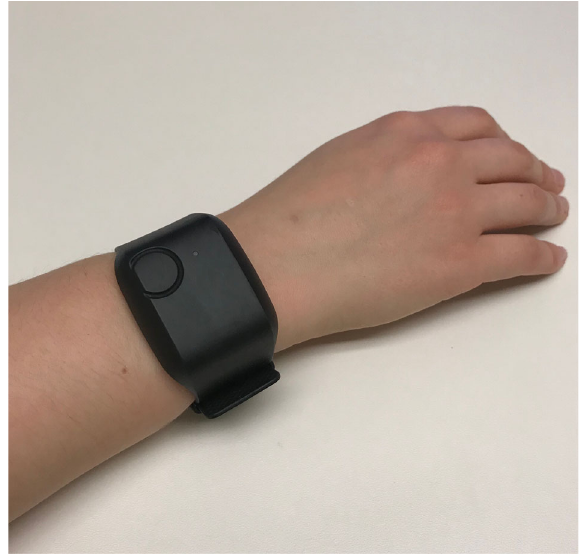
Fig. 9 Empatica E4. Photo by author, device purchased by